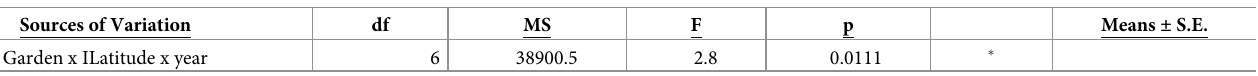
tively; p = 0.0050, p = 0.0077 and p = 0.0463, respectively). The continent effect comparing the reaction norm slopes in Eurasia vs. North America show that Eurasia had the larger values for reaction norms for above-ground and total biomass (Figs 2 and 3). Note that Q norm for log total biomass were both significant, whereas for log inflorescence, reaction vs. inflorescence biomass: 0.117 vs. 0.049, respectively). The QST values for above-ground, respective; p <